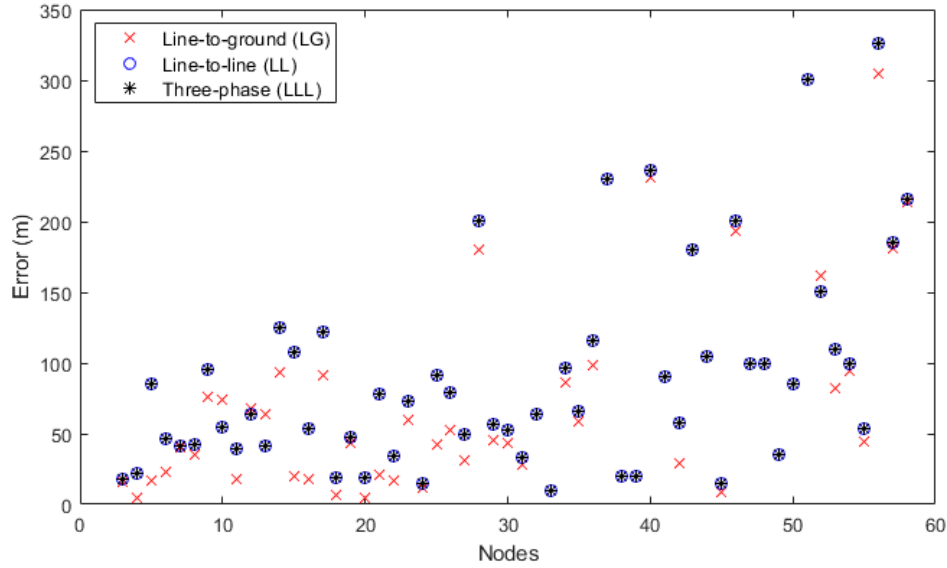
Figure 10. Fault location error for different types of faults.